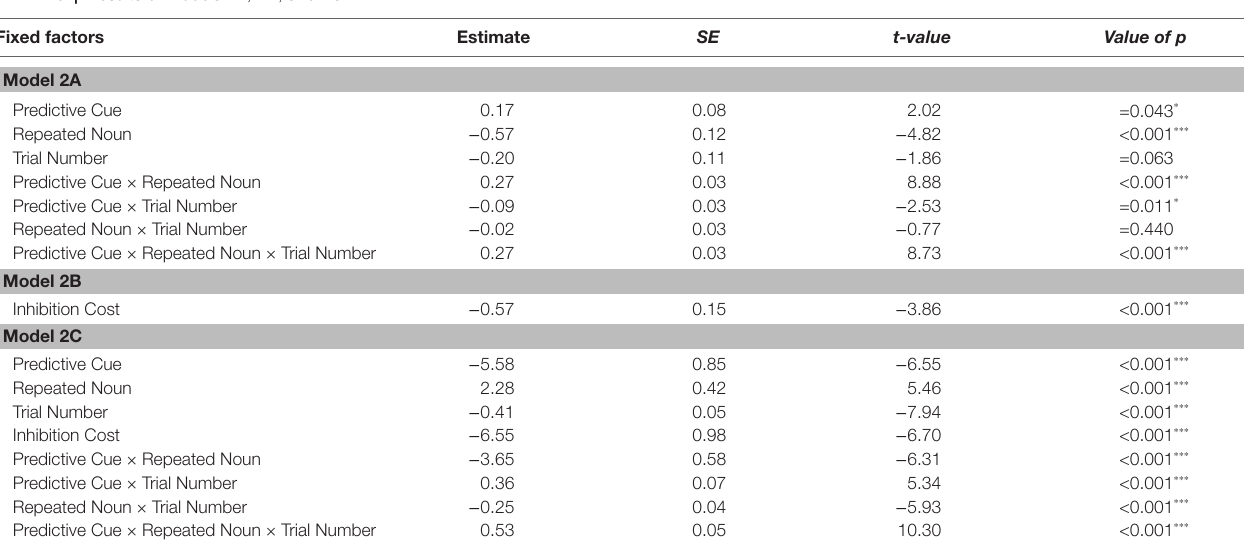
TABLE 3 | Results of Models 2A, 2B, and